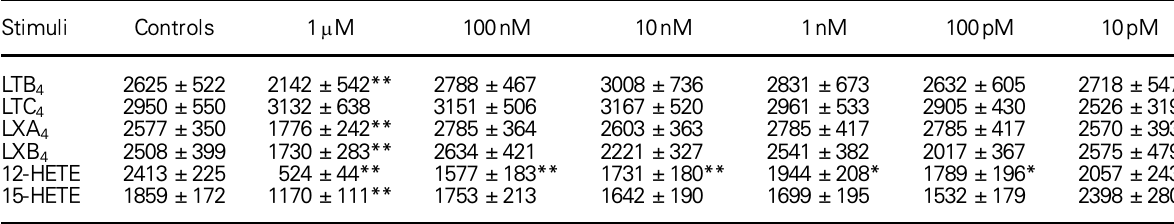
Table 1. Effects of lipoxygenase AA metabolites on [ 3 H]-thymidine incorporation of human bone marrow stromal cells. Experiments were made with stromal cell cultures from 30 donors. Results (in dpm) are the mean ± SEM from six independent experiments in sixplicate ( n = 6) Stimuli